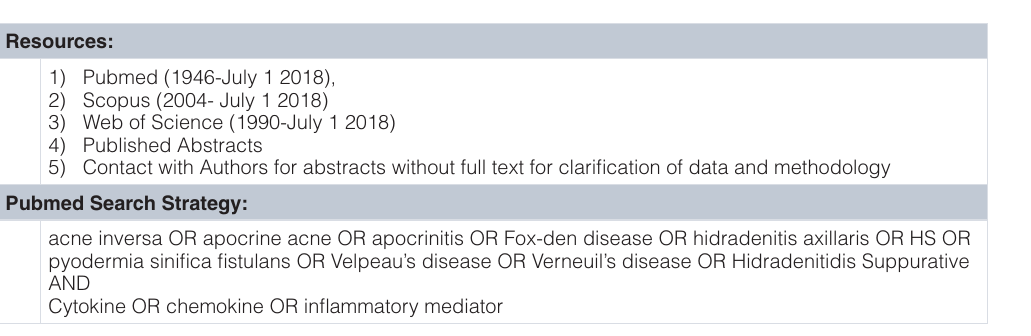
Table 1. Search Strategy.